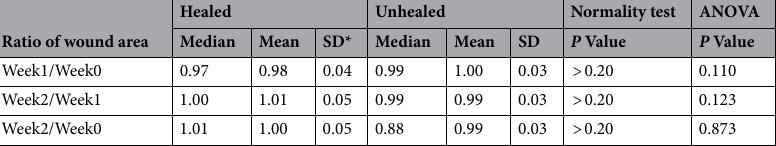
Ratio of wound area